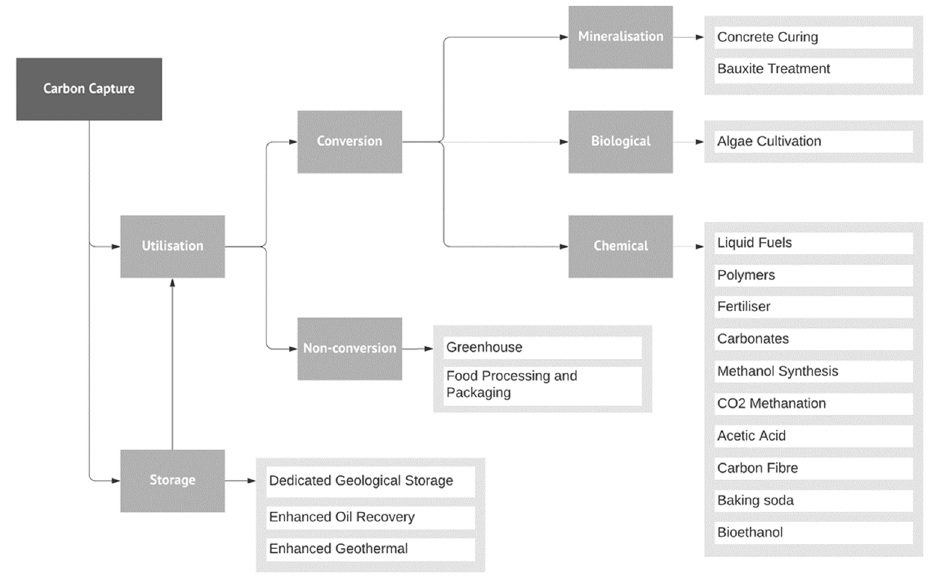
Figure 1. The diagram to illustrate the pathways of carbon utilization and storage post-capture as described in the Global Status Report 2019 of the Global CCS Institute.